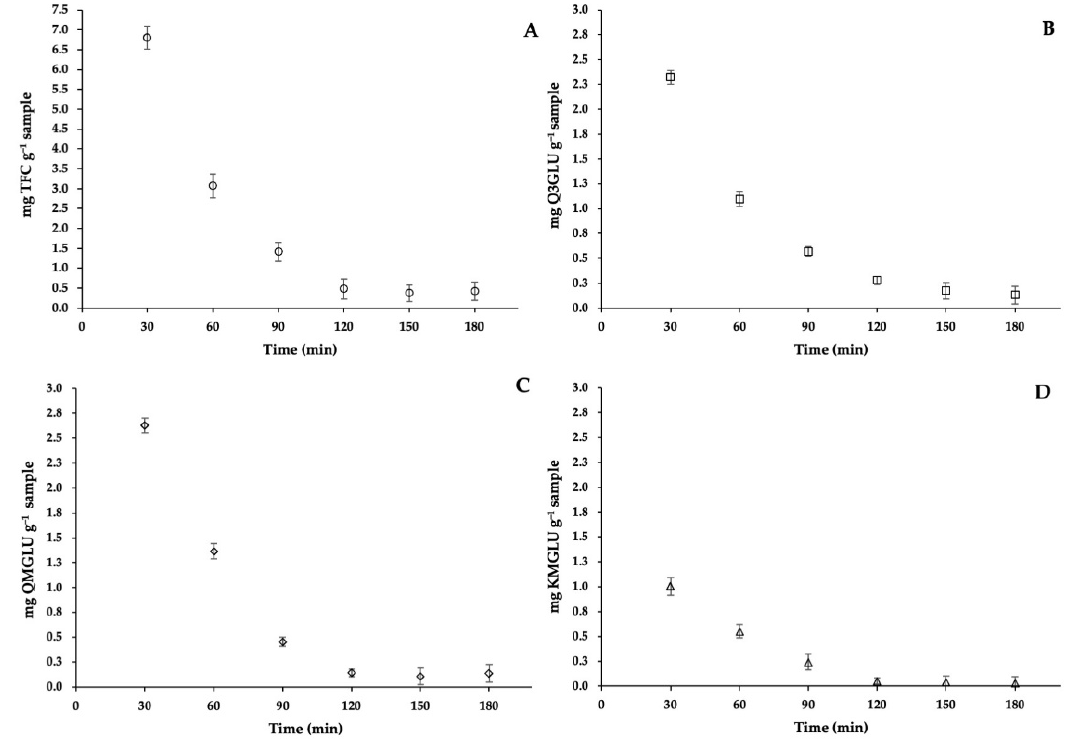
Figure 4. Extraction kinetics of the supercritical CO 2 extraction of TFC ( A ), Q3GLU ( B ), QMGLU ( C ) and KMGLU ( D ) from moringa leaves under optimum pressure and temperature conditions. The data are expressed as mean ± standard deviation.